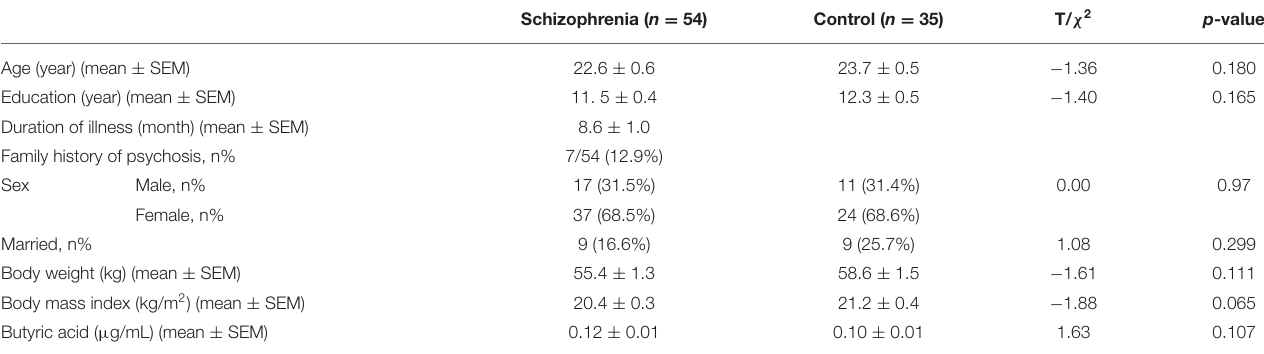
TABLE 1 | Demographics and baseline serum levels of butyric acid in schizophrenia patients and healthy